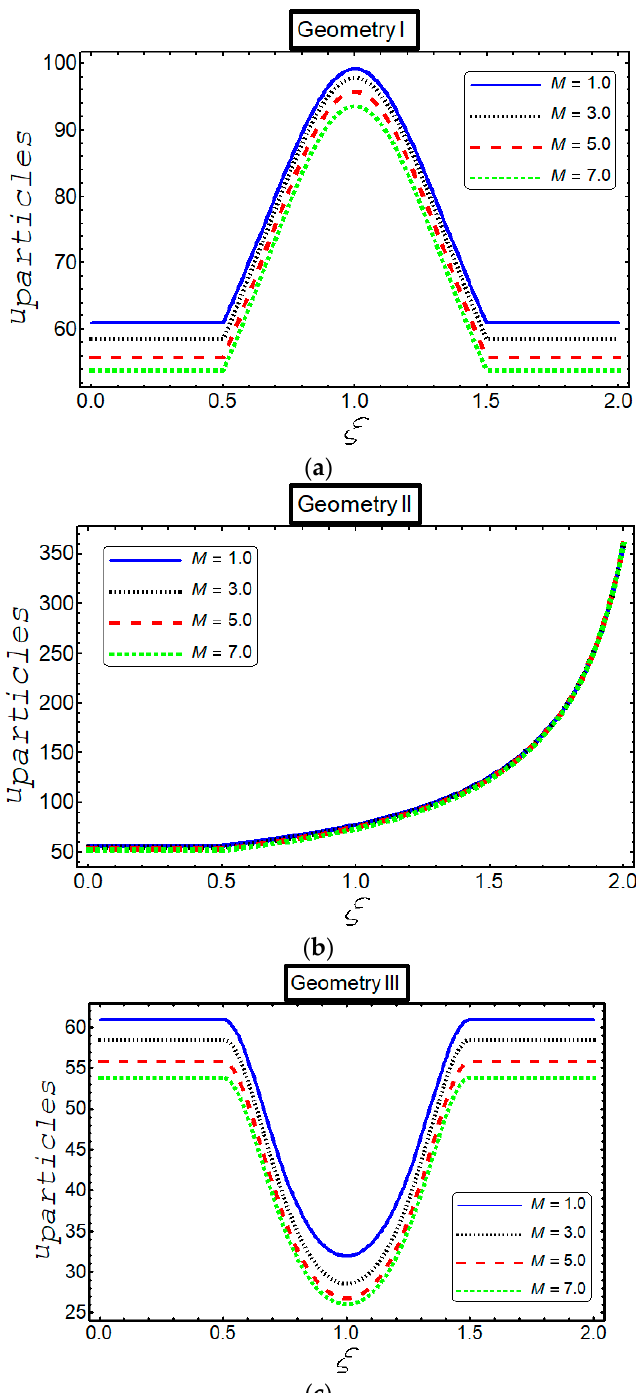
Figure 5. Velocity variation for Hartmann number.